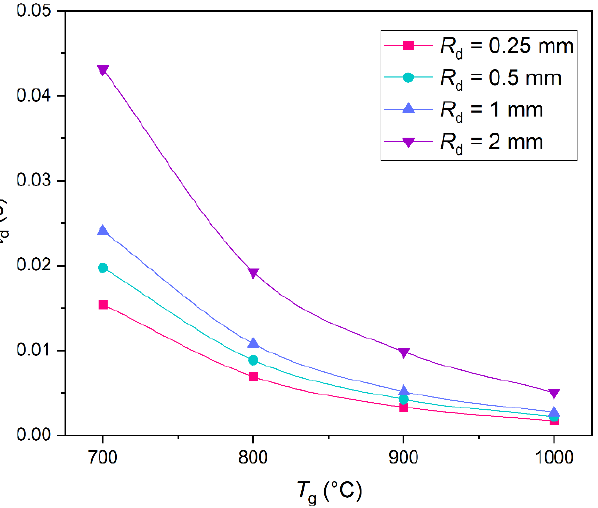
Figure 3. Double gas hydrate ignition delay time versus the heating source temperature T g with varying hydrate particle size R d under radiative heating.